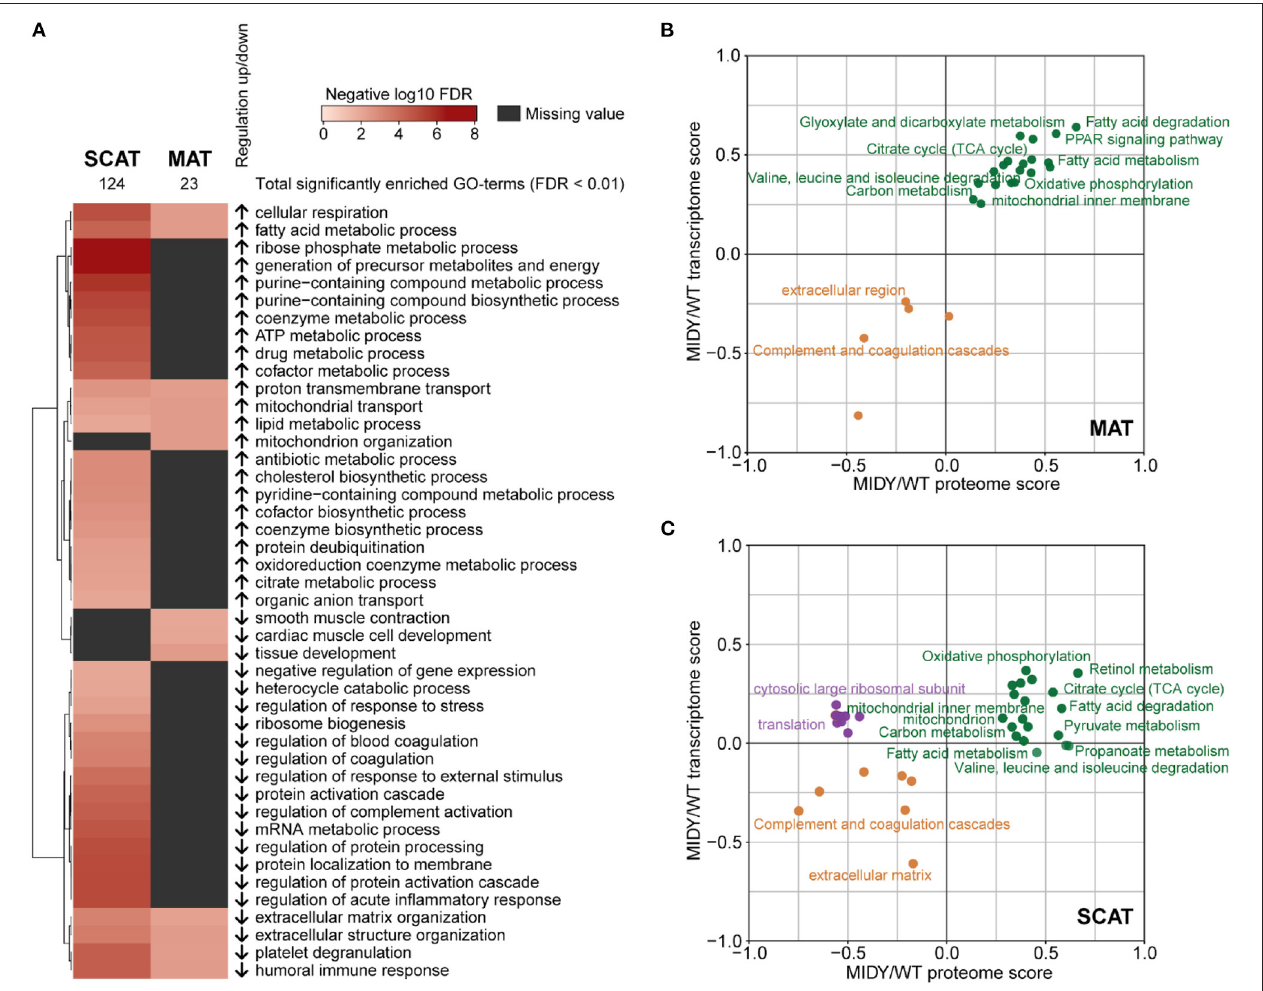
FIGURE 3 | Multi-omic functional characterization of MIDY adipose tissue (A) Annotation enrichment analysis of SCAT and MAT proteome alterations in MIDY. Heatmap shows GO-term enrichment in MIDY compared to WT. Enrichment analysis was performed using a pre-ranked STRING analysis and an FDR cutoff of 0.01. Significantly enriched GO biological processes were summarized with REVIGO by grouping semantically similar ontology terms. Arrows indicate regulation in MIDY. (B,C) 2D annotation enrichment analysis showing the correlation of proteomics and transcriptomics data. Fold-changes in the proteome (x-axis) and transcriptome (y-axis) are rescaled and shown as scores. Terms depicted in green dots show a common upregulation at the transcriptome and proteome level. Terms in orange show a common downregulation. Purple dots indicate downregulation at the proteome level and upregulation of corresponding mRNA levels. Significant KEGG pathways and Gene Ontology categories with FDR < 0.1 are